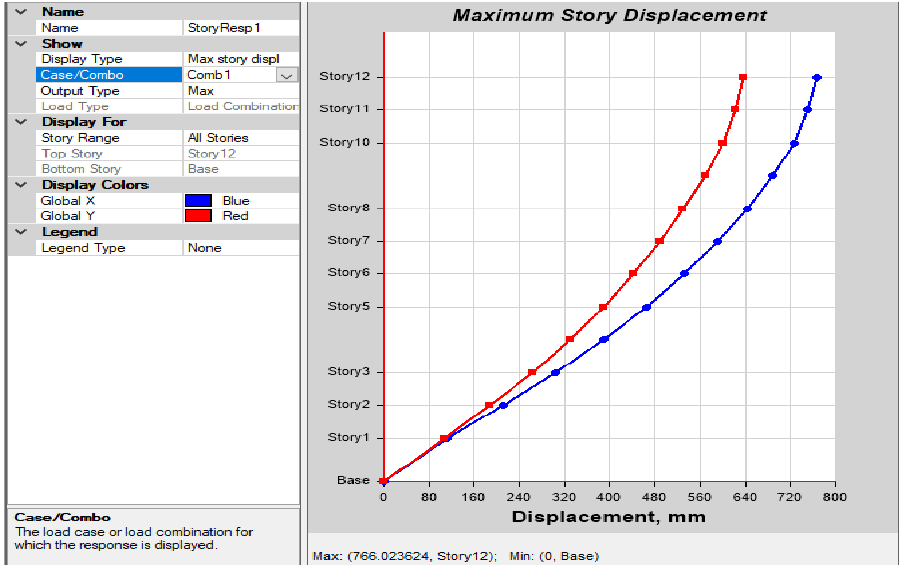
Figure 9. Maximum story displacement.